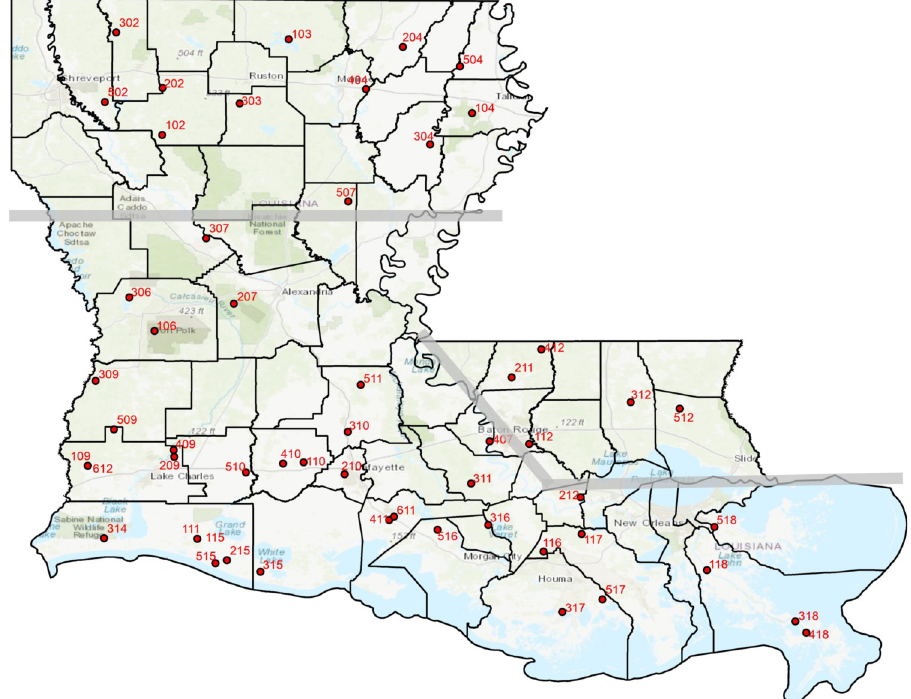
Fig 1. Approximate locations of LAMP routes and regions in this study. The dots show approximate route locations. The numbers are the last three digits of the 6-digit NAAMP route number. The broad gray lines delineate the regions and the black lines are parish (i.e., county) or state boundaries. The South and Florida regions used the same observation windows (see Table 2). The Florida region is comprised of the ‘Florida Parishes’, locations east or north of the Mississippi River. The areas west of the Mississippi River are divided at approximately 31˚41’N latitude. See S1 Table for a list of full NAAMP route numbers and the latitude and longitude of the first stop.